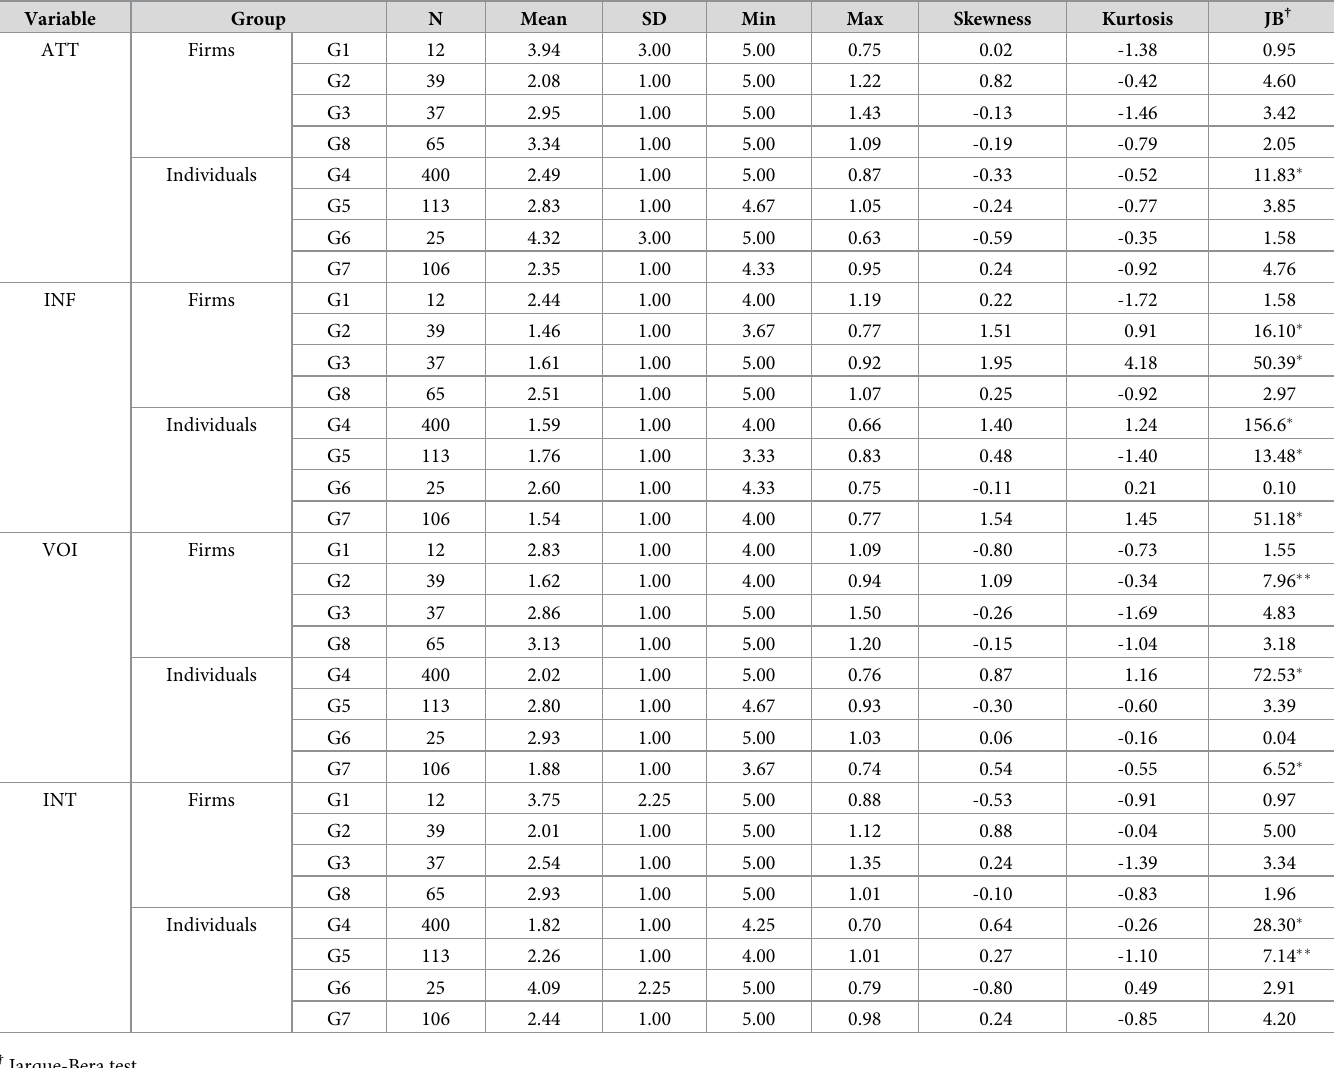
Table 4. Descriptive statistics and goodness-of-fit Jarque-Bera test of the variables. Variable Group ATT